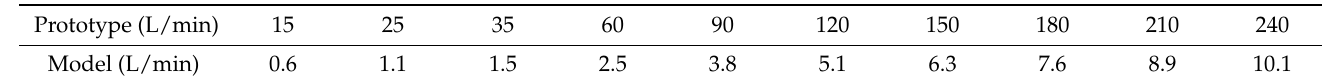
Table 3. Blowing volume of prototype and